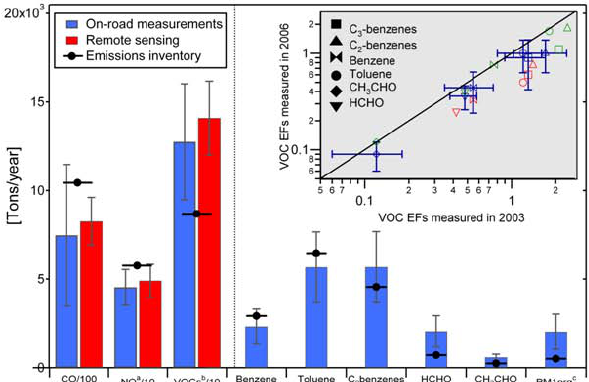
Fig. 7. Comparison among LDGV on-road mobile emissions es- timated during MILAGRO, remote sensing measurements in 2006 (Schifter et al., 2008) and the mobile emissions inventories (SMA- GDF, 2008a, b). The uncertainty bars displayed are standard errors of the means. For clarity, emissions of CO, NO, and VOCs are di- vided by factors of 100, 10 and 10, respectively. The upper-corner inset shows a comparison of on-road VOCs fuel based emission fac- tors (EFs, g/kg) measured in 2003 and 2006 with the ARI mobile laboratory in Mexico City for SAG (green), TRA (blue) and CRU (red) driving conditions (see Zavala et al 2009a for definitions of driving conditions). Error bars are shown for TRA driving condi- tions and represent one standard deviation of the measured values. Notes: a NO x (expressed as NO 2 ) emissions in the inventory were assumed 90% NO and 10% NO 2 in mass. b Total VOCs emissions from the inventory include evaporative emissions. The correspond- ing on-road VOC’s are inferred rather than measured scaling CO emissions by a remote-sensing-based VOC/CO ratio (Schifter et al., 2008). Estimated organic mass of particles in the non-refractory PM 1 range. The PM mass from the emissions inventory refers to PM 2 . 5